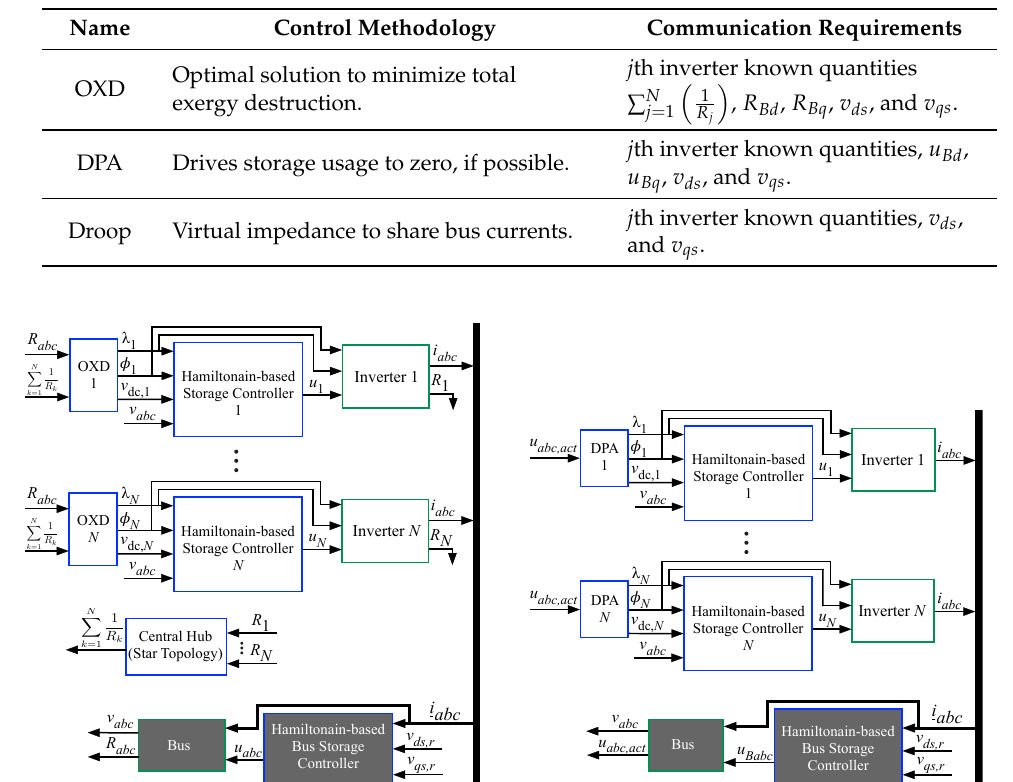
Figure 3. ( a ) OXD block diagram. ( b ) DPA block diagram. The j th inverter known quantities have been omitted, for